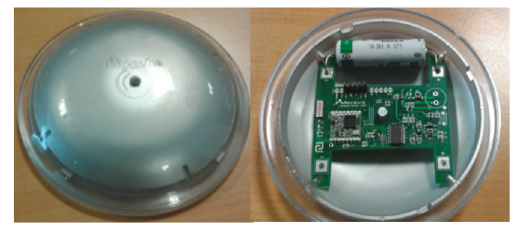
Figure 5: Deployed